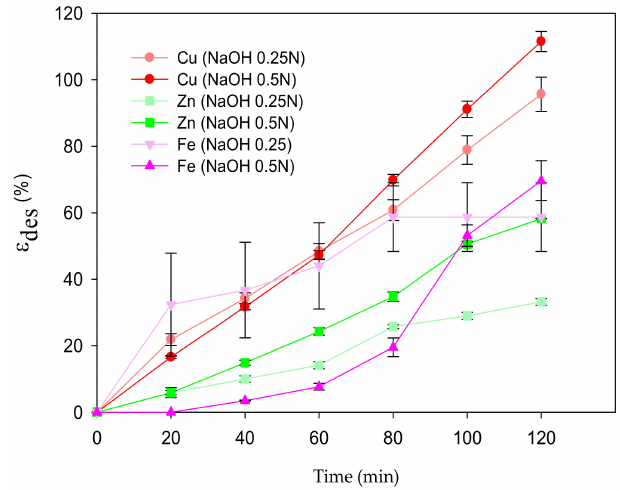
Figure 9. Desorption efficiencies of metal ions from